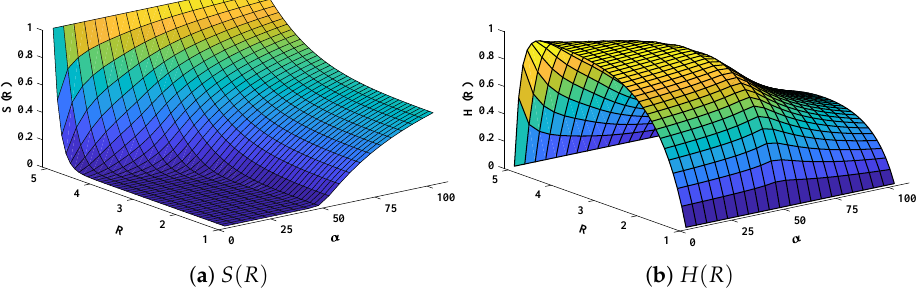
Figure 16. Plot of three dimensional ( a ) concentration profiles of substrate and ( b ) hydrogen peroxide against dimensionless distance R and Saturation parameter α . Reaction–diffusion parameters are equal to 50.